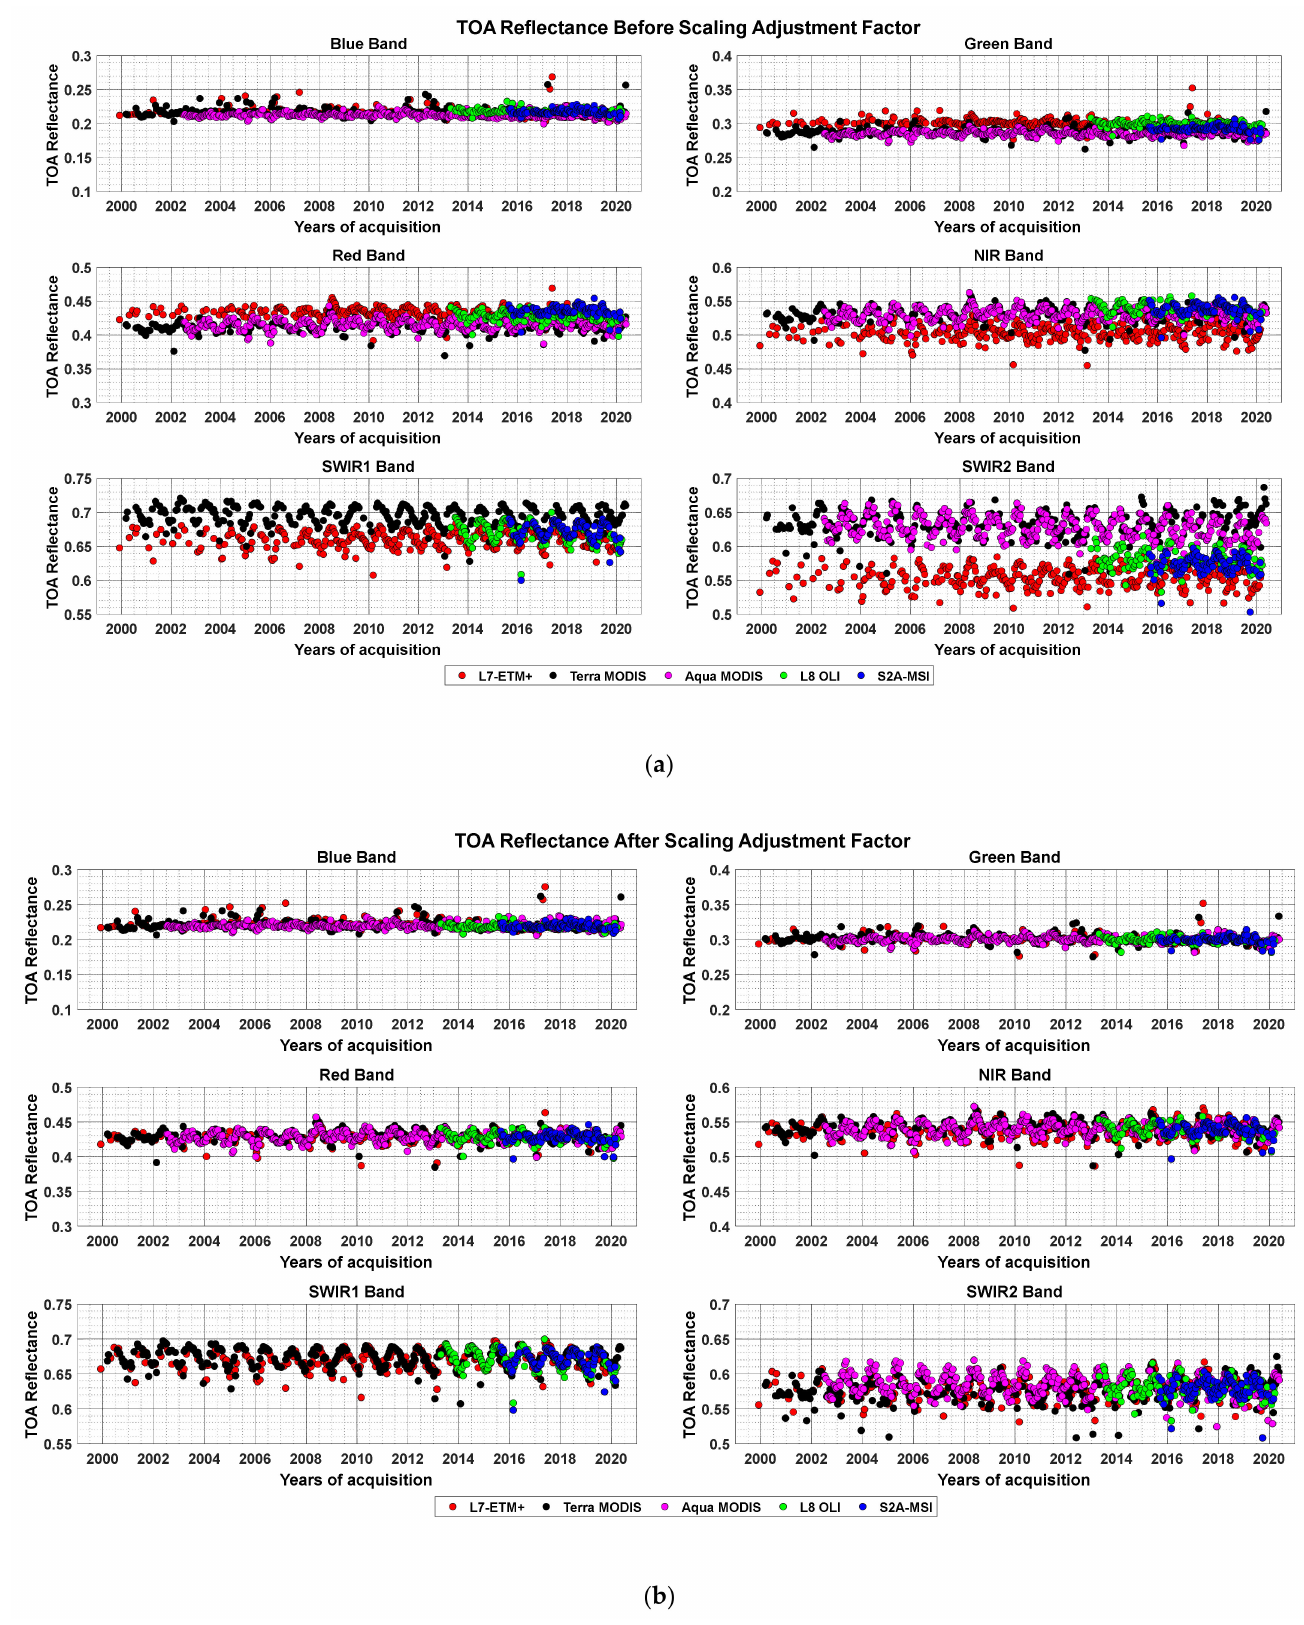
Figure 3. Temporal trend of before ( a ) and after ( b ) scaling adjusted TOA reflectance over Sudan 1 site for the combined dataset (ETM+, Terra MODIS, Aqua MODIS, OLI, and